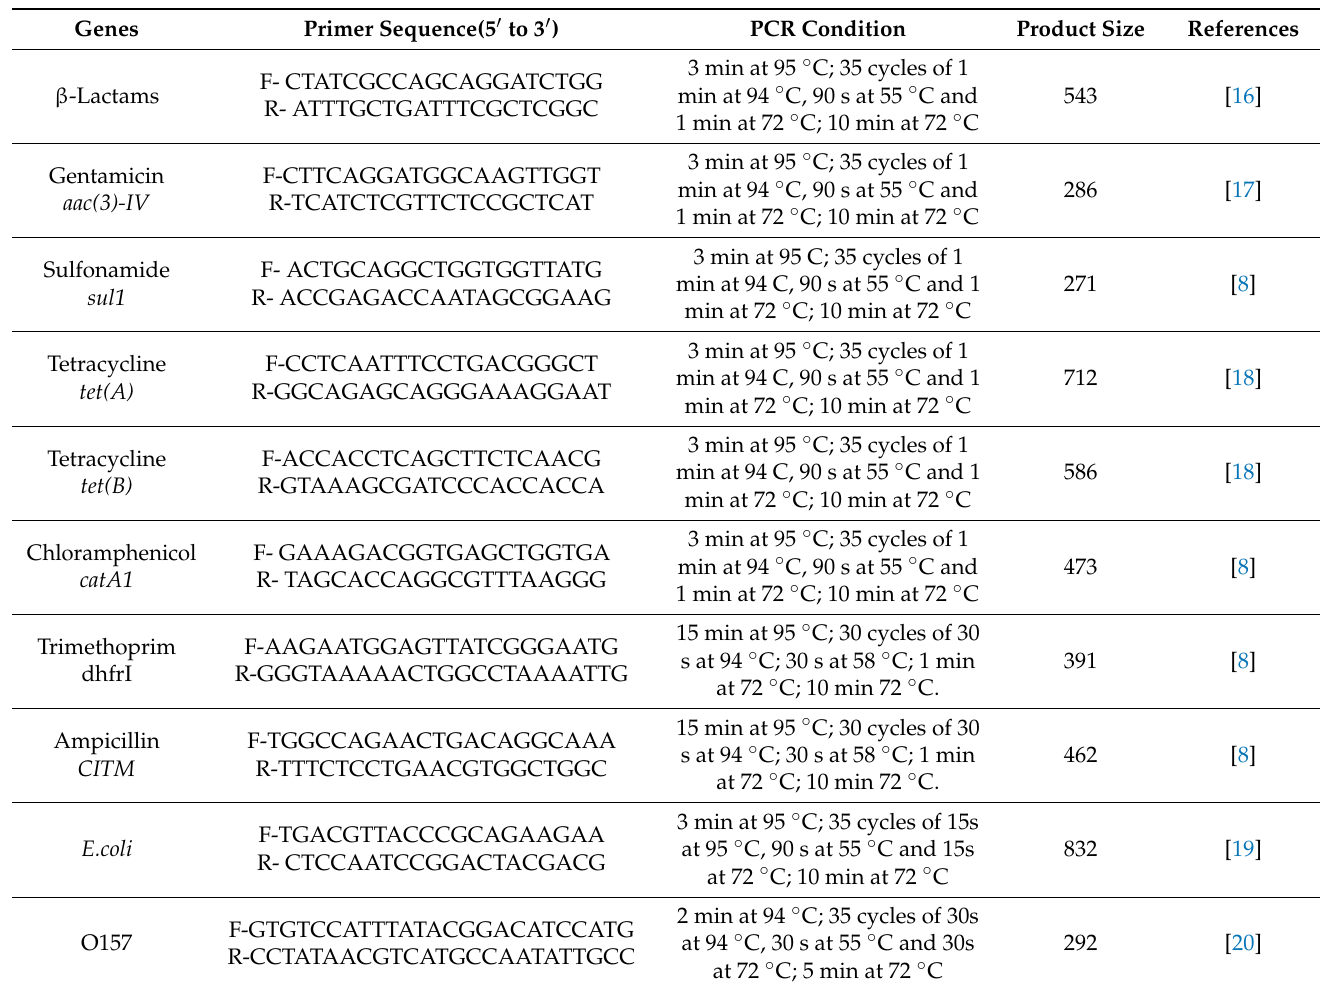
Table 7. The set of primers used for each